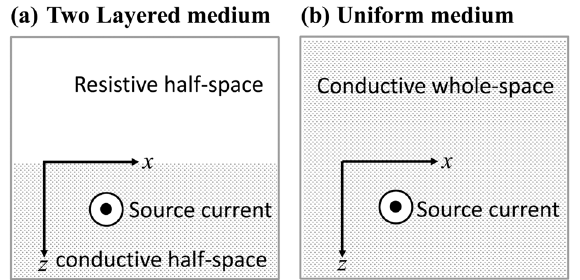
Figure 2. The two models for which formulas are derived in this paper. The direction of the y -axis is chosen such that the x -, y - and z -axes form an orthogonal, right-handed, Cartesian